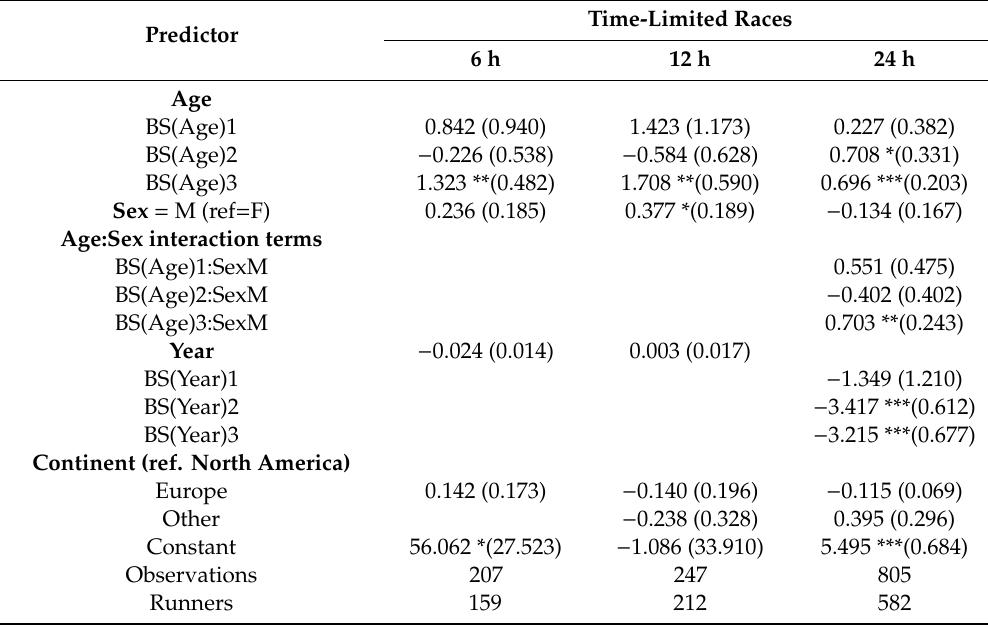
Table 3. Regression analysis (mixed model) of ultra-endurance events (6, 12 and 24 h). Estimates and standard errors (SE) of fixed e ff ects are reported. p -values ranges are marked with asterisks (see note). Smoothing terms, basis splines (BS), are denoted with BS(x) t, where x = year, age; t = 1,2,3.